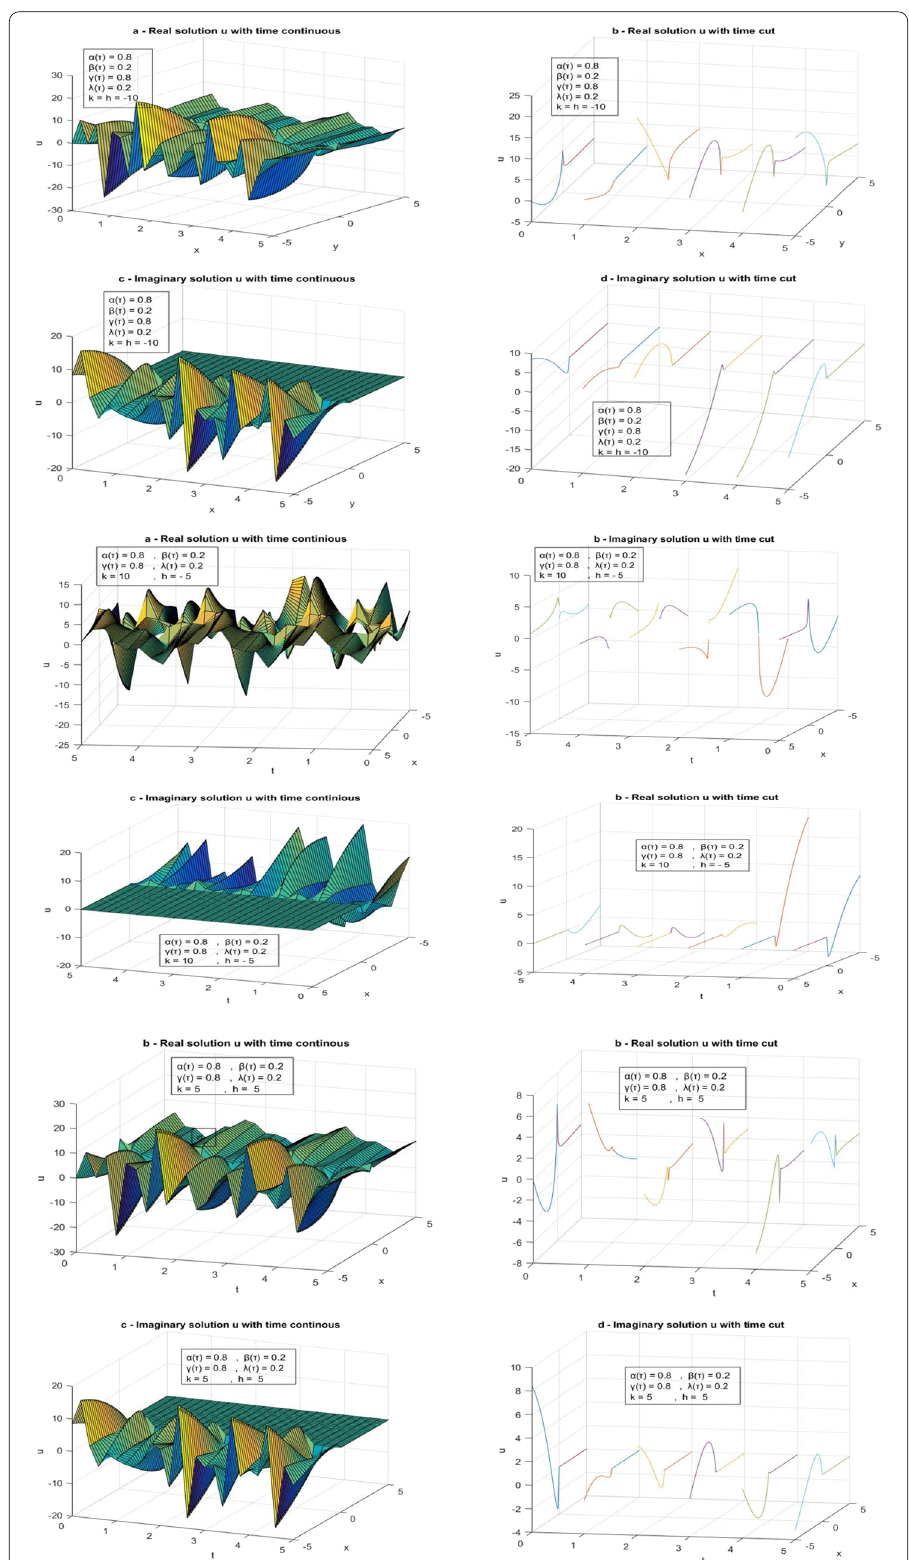
Figure 3 The graph of u in Example 1 with different values for α ( τ ), β ( τ ), γ ( τ ), λ ( τ ), k , and